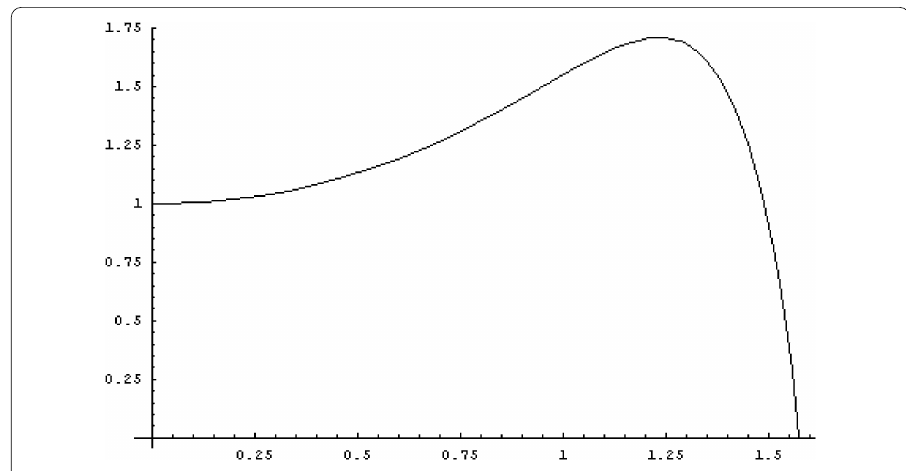
Figure 6 The graph of the function d ψ / d θ , where θ ∈ (0, π